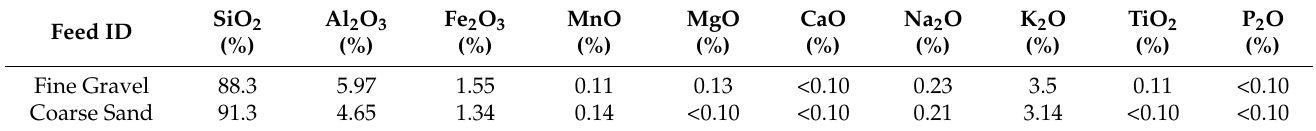
Table 7. Chemical analysis